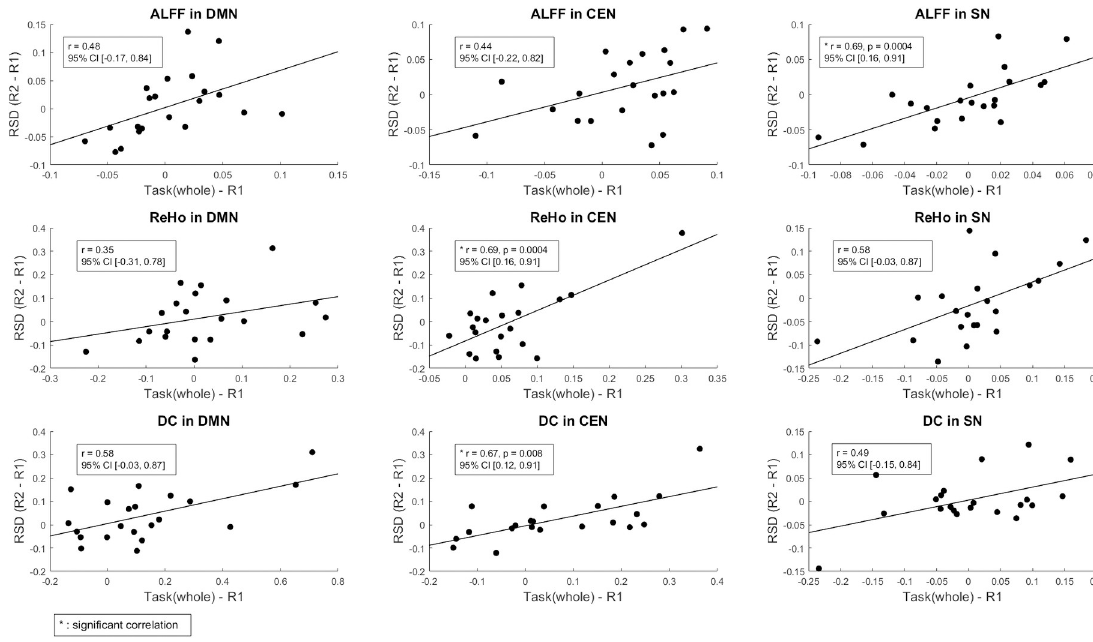
Fig 6. Correlations between the fMRI measures resulting from the pure task (whole) effects and the RSD in the triple network, including the DMN, CEN, and SN of the fMRI measures.